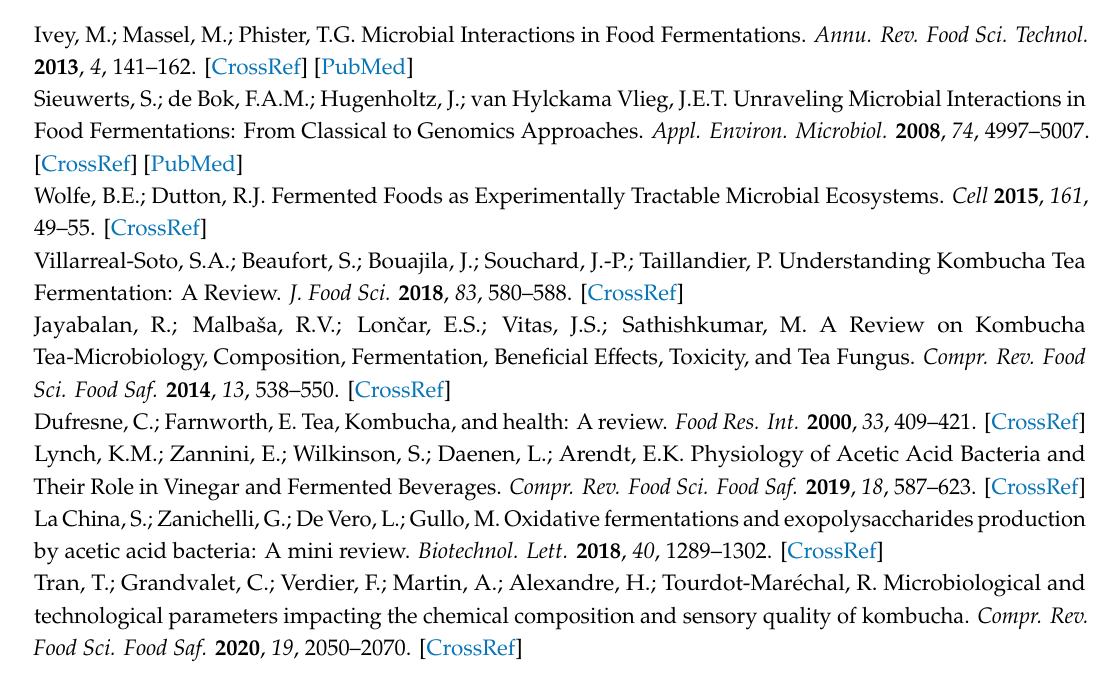
Figure S1: Sum-up diagram of the experiment, Table S2: Description of research samples with abbreviations, Figure S3: Hypothetical “snowball e ff ect” explaining sucrose hydrolysis by acetic acid bacteria. Author Contributions: Conceptualization, validation, methodology, and visualization, T.T., C.G., and